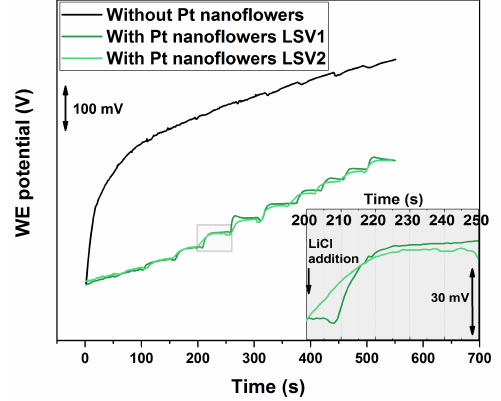
Figure 4. Calibration time traces of lithium-ISE fabricated on different solid-contact (SC). LiCl was added every 50 s to achieve a half-log increase of the concentration.